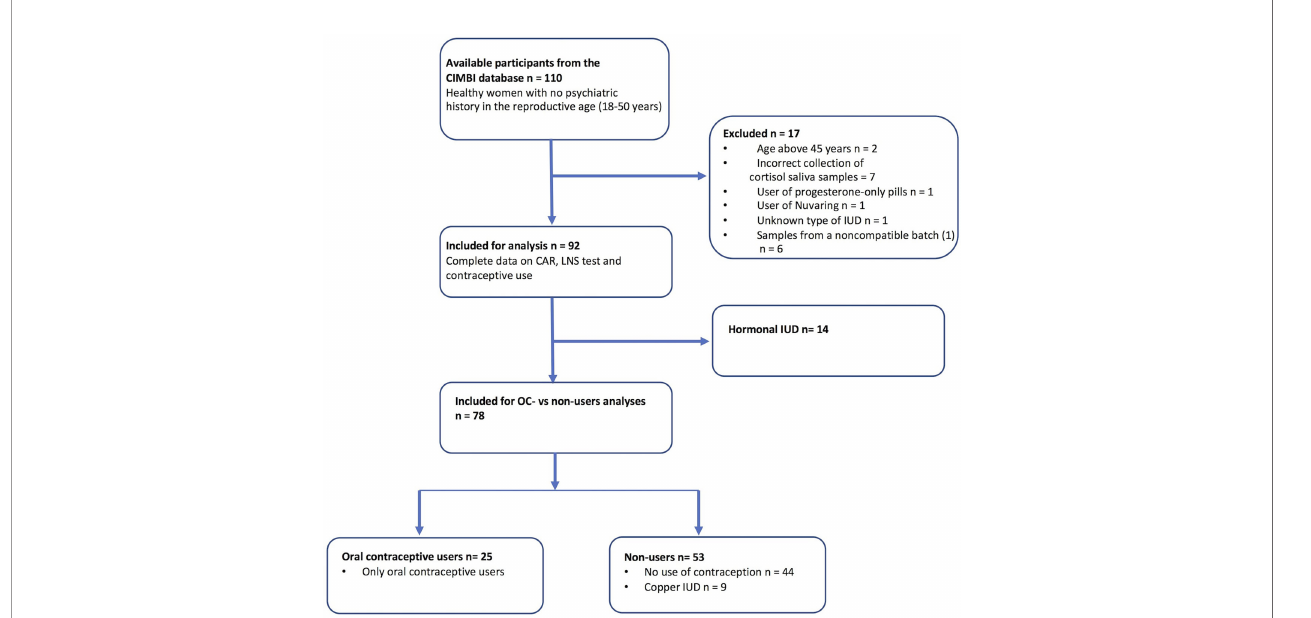
FIGURE 1 | Overview on study population selection from the CIMBI database. Participants recruited from the Center for Integrated Molecular Brain Imaging (CIMBI) database. Inclusion criteria were healthy women with no psychiatric history in the reproductive age <50 years. A complete dataset was required with concurrent information on cortisol awakening response (CAR), Letter-Number-Sequence (LNS) test, and contraceptive use. Exclusion criteria were (1) women above 45 years of age with early menopause or unknown menopausal status measured with follicle stimulation hormone (FSH), (2) incorrect collection of home cortisol samples, and (3) hormonal contraceptives other than OCs or intrauterine devices (IUDs). Further, six women had incomparable cortisol data due to batch variations of the cortisol saliva